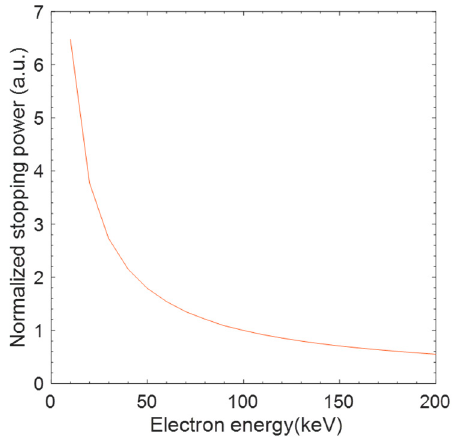
Figure 8. Stopping power for incident electrons normalized at 100 keV electron energy in ZrO 2 .